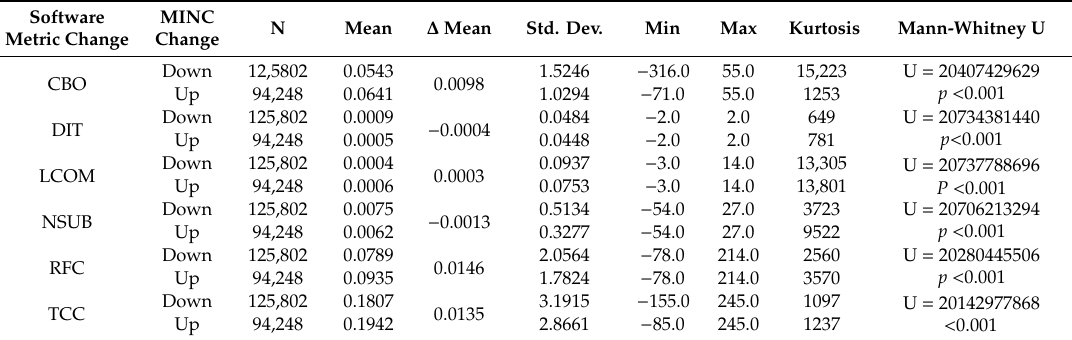
Table 8. Descriptive statistic values of changes of software metrics grouped by the change of MINC.